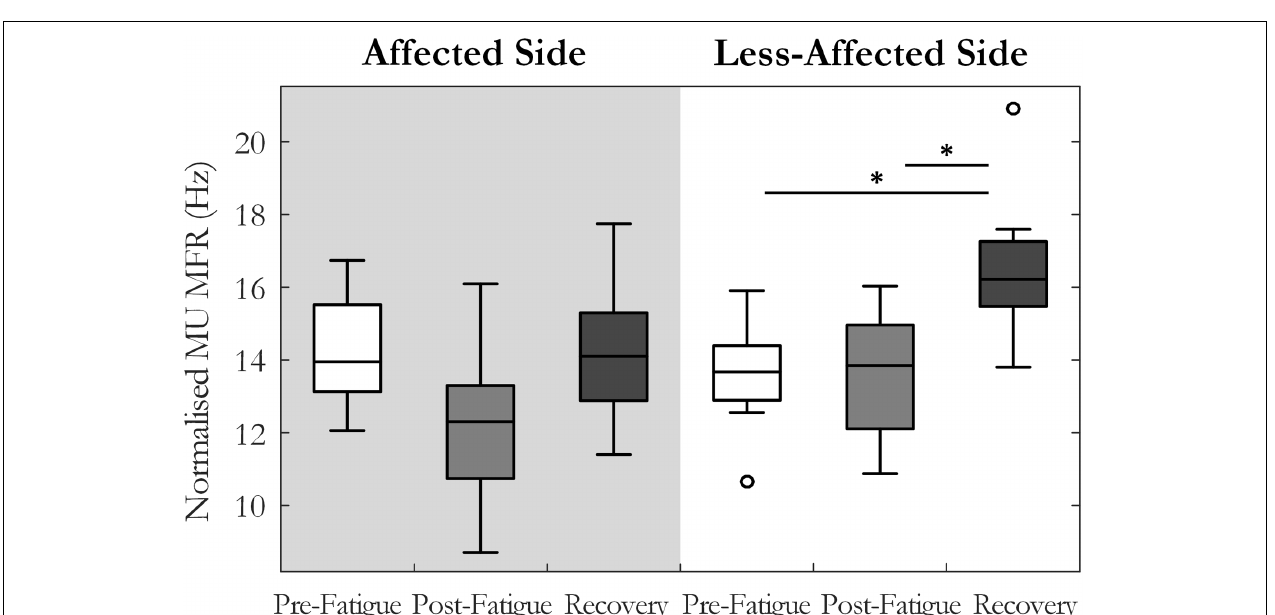
FIGURE 3 | Median and interquartile range of median MU firing rate across all subjects from MUs detected pre-fatigue, post-fatigue, and after the recovery period, on both the affected and less-affected sides ( ∗ p < 0.05).